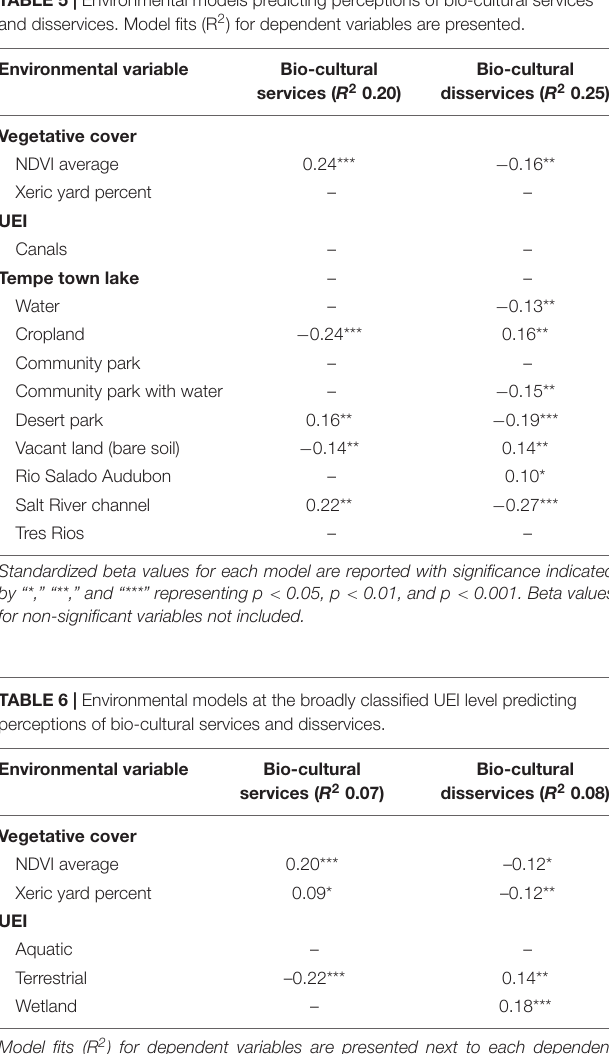
TABLE 5 | Environmental models predicting perceptions of bio-cultural services and disservices. Model fits (R 2 ) for dependent variables are presented.